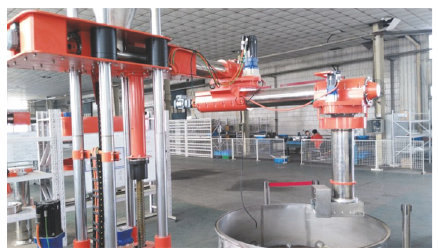
Figure 15: Experimental prototype of steamer-filling robot.